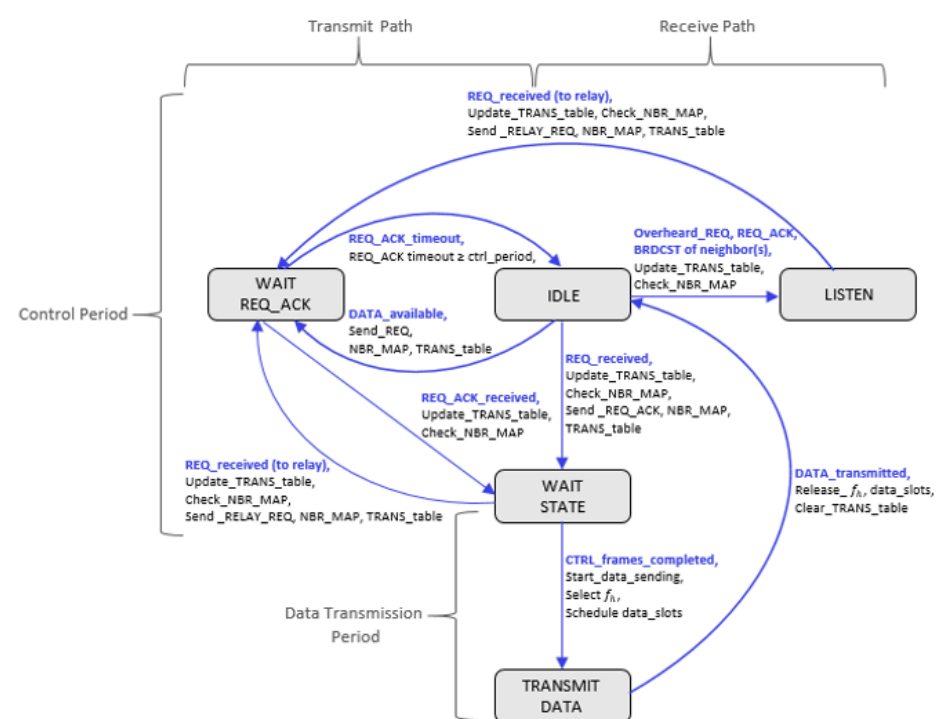
Figure 16. Finite state machine for control and data